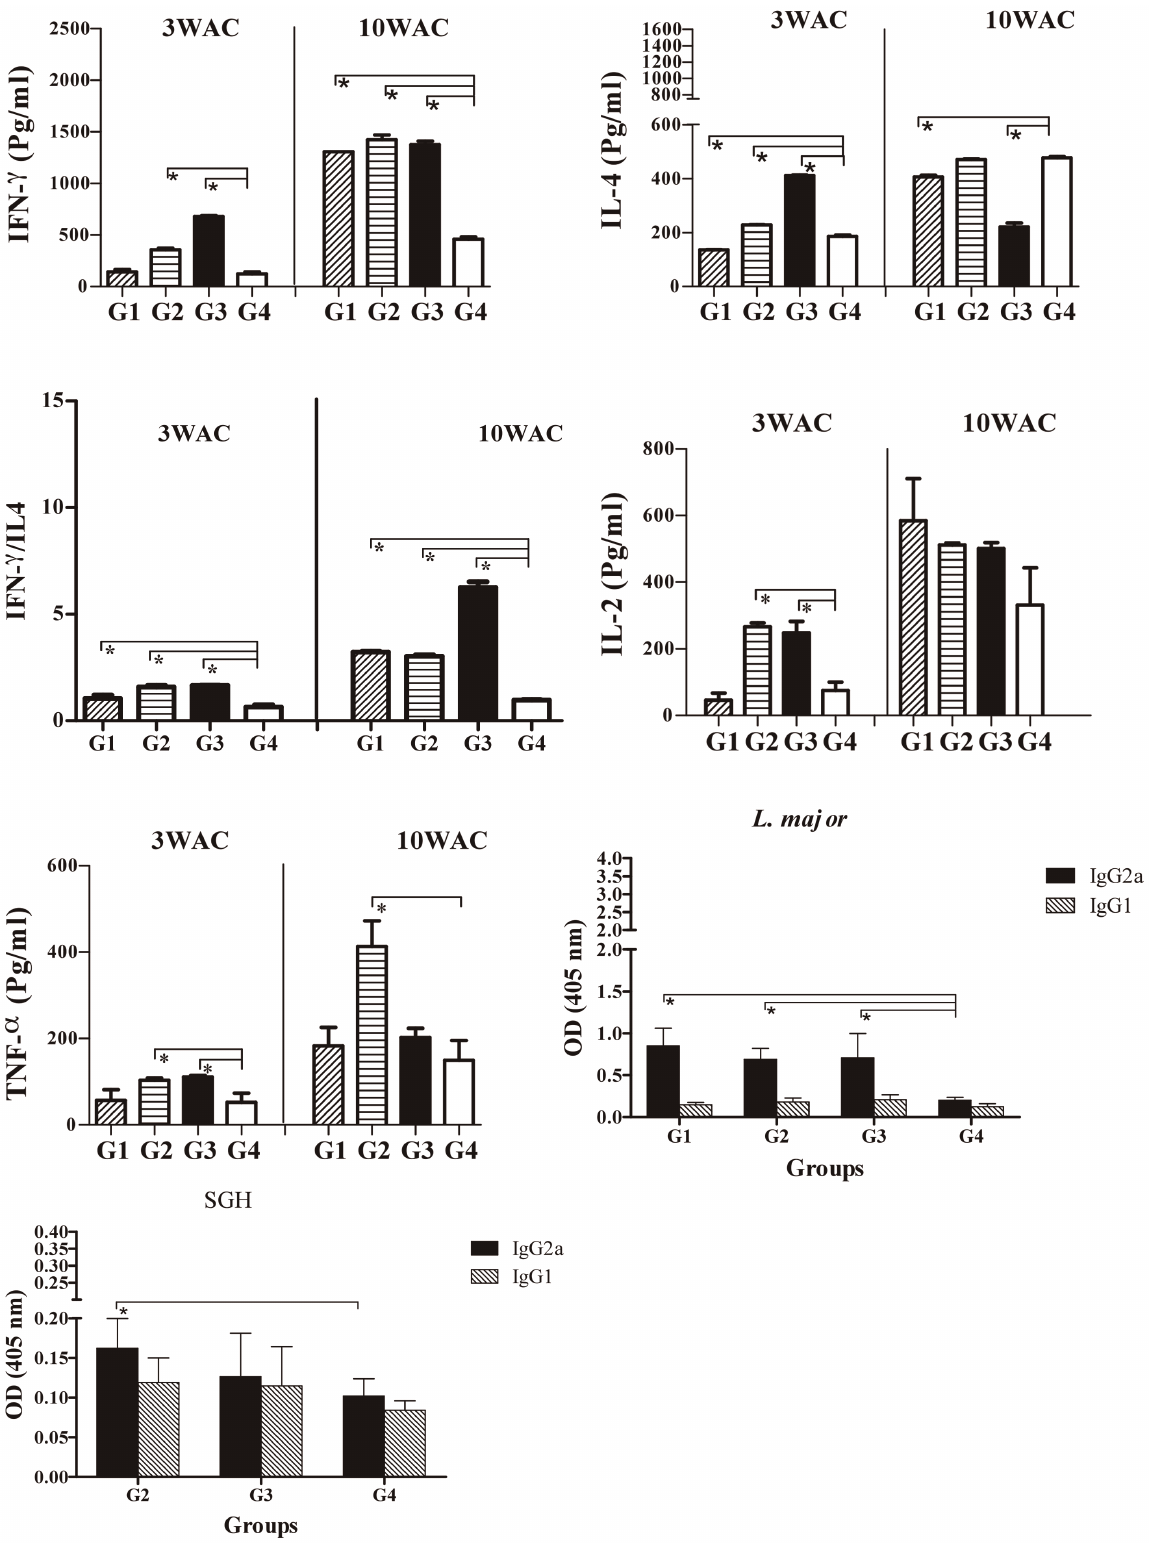
Figure 7. The immune response post-challenge in C57BL/6 mice vaccinated with different modalities. A–E, Cytokine production by splenocytes at 3 and 10 weeks after challenge. Single cell suspensions were prepared from splenocytes of four C57BL/6 mice at 3 and 10 weeks after infectious challenge. Cells were cultured in duplicate in the presence of freeze-thawed L.major + SGH for G2, G3 and G4 and with only L. major for G1. Culture supernatants were assayed for the level of IFN- c (A), IL-4 (B), ratio of IFN- c to IL-4 (C), IL-2 (D) and TNF- a (E) production by ELISA. Each bar represents the Mean 6 SD of 4 mice per group. Data were analyzed by the Mann Whitney test. Asterisks indicate the statistical differences between